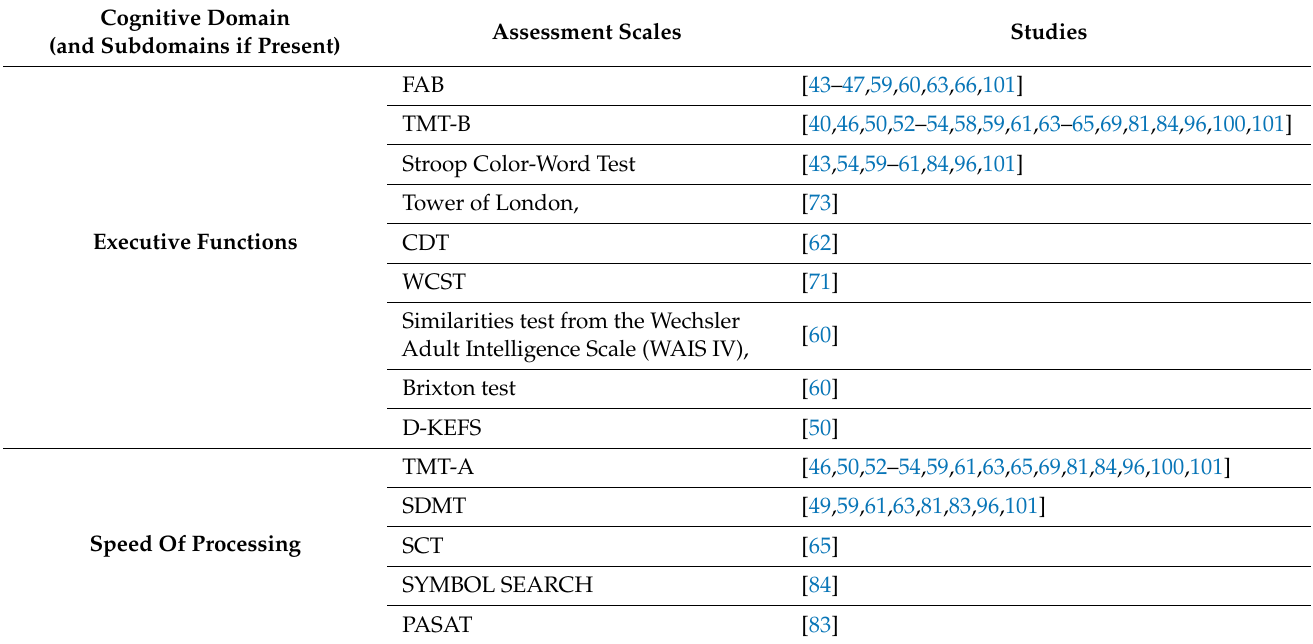
Table 1. List of the tests employed to assess specific cognitive